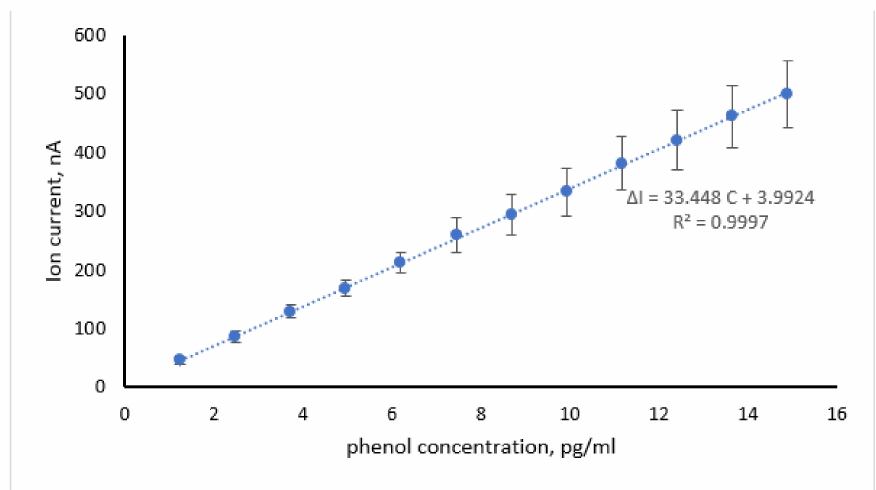
Figure 6. Calibration graph for phenol detection using metal-supported PC membranes incorporating tyrosinase (2.5 µ g/mL, concentration in bulk). Experimental conditions: pH 8.0; 0.5 mm Teflon coated Ag wire; 0.1 KCl solution with HEPES; 25 ◦ C. Error bars denote standard deviation ( n = 31). For more details, see text.